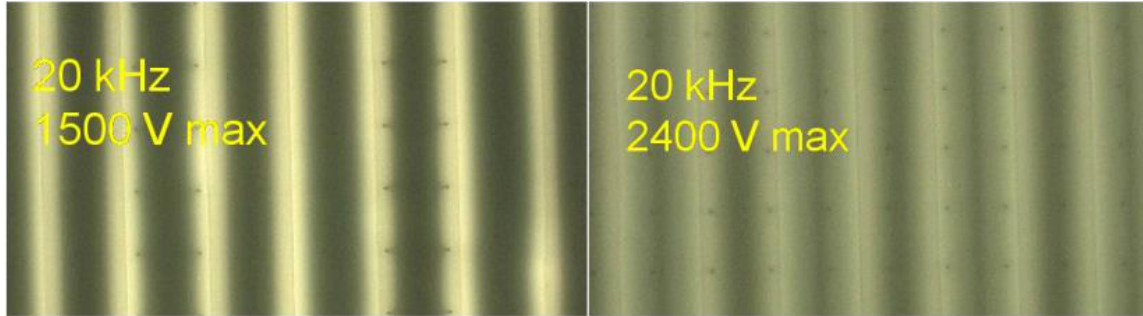
Figure 11. Pictures of the lamp with complementary coplanar electrodes for two voltages at 250 mbar and 20 kHz.